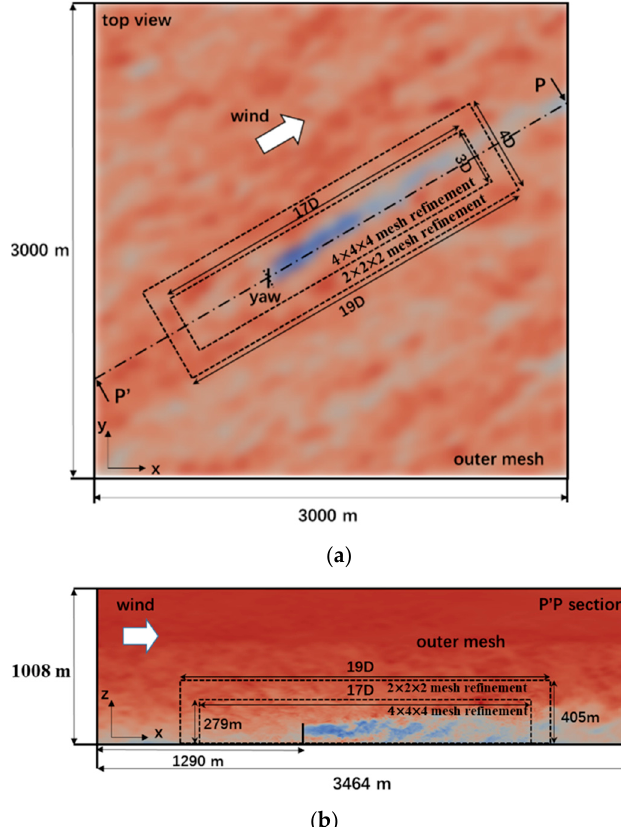
Figure 2. Overview of the simulation setup: ( a ) horizontal section at turbine hub height; ( b ) vertical section through the center of the wind turbine.